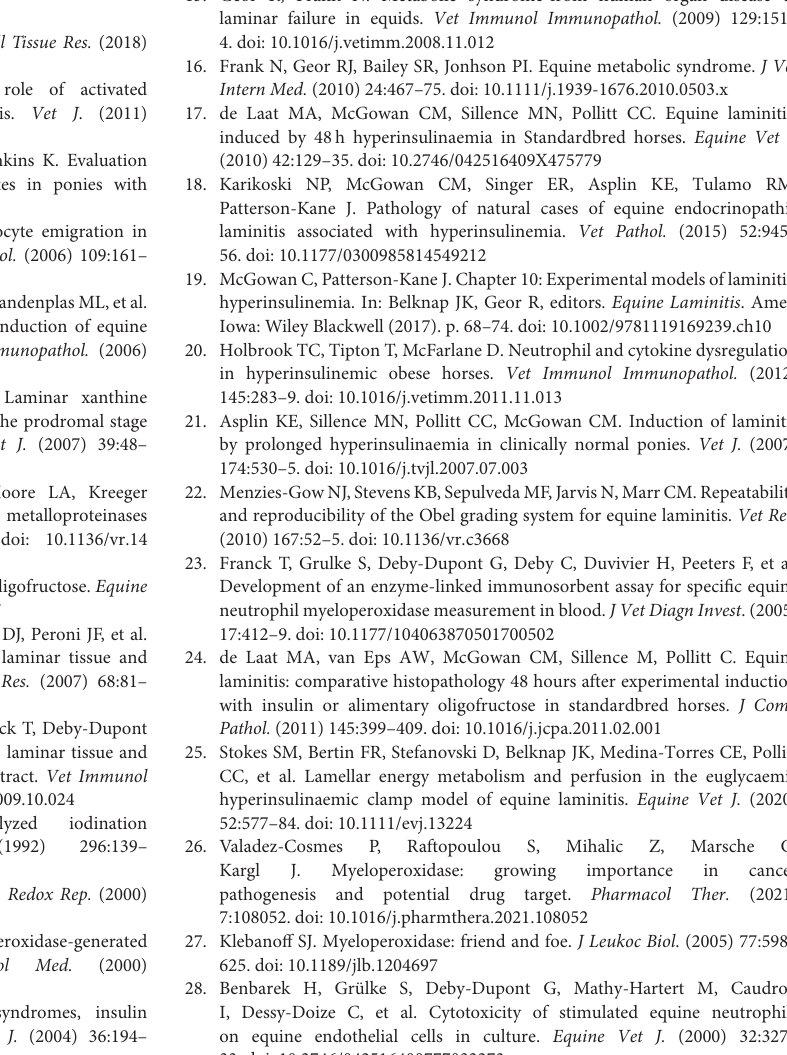
Supplementary Figure S1 | Reconstruction of photomicrographs of the dermo-epidermal interface of a control horse stained with HE and anti-MPO ( × 100). The dermal side is to the left and the epidermal side is to the right. Supplementary Figure S2 | Reconstruction of photomicrographs of the dermo-epidermal interface of a pEHC-treated horse stained with HE and anti-MPO ( × 100). The dermal side is to the left and the epidermal side is to the